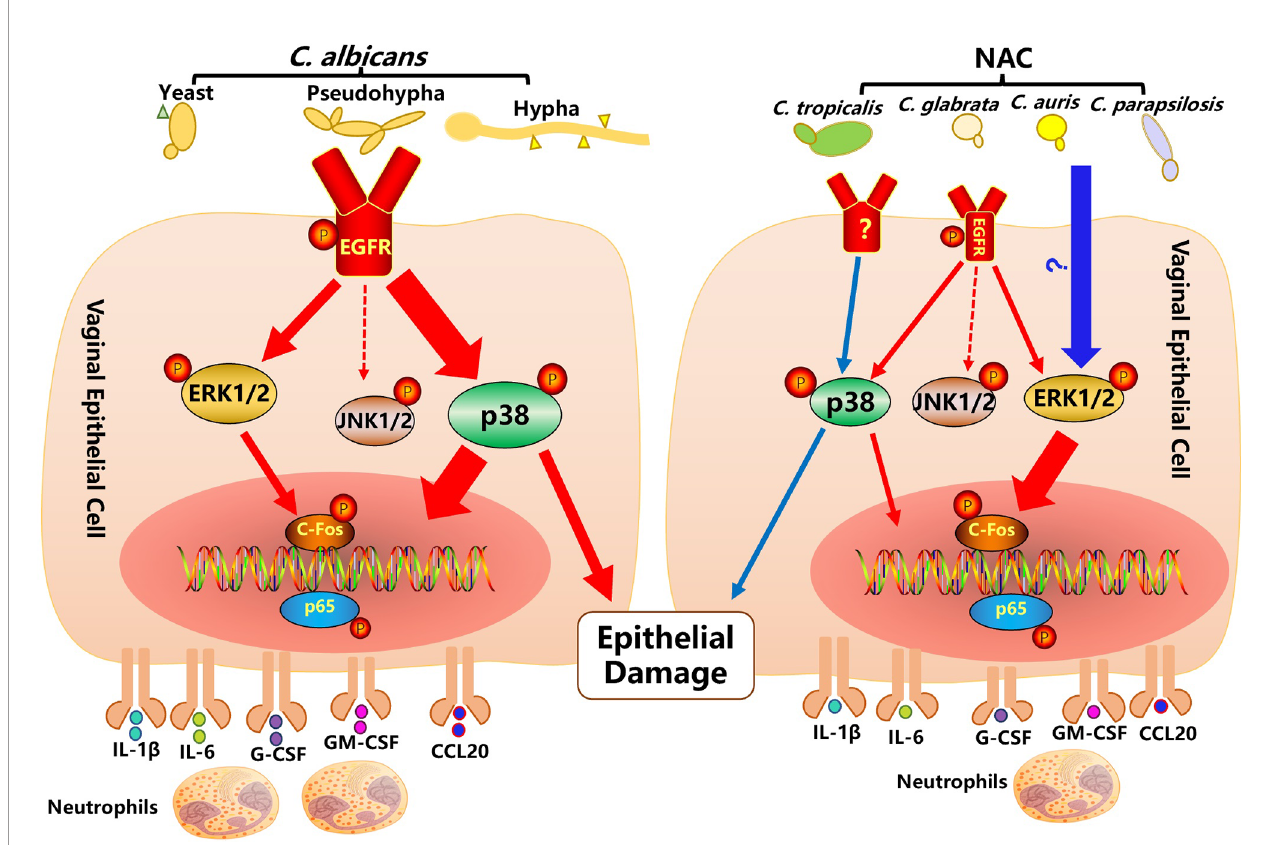
FIGURE 7 | Activation of the EGFR-MAPK signaling pathway in vaginal epithelial cells by Candida pathogens. C. albicans infection on vaginal epithelial cells manifests by a modest yeast-to-hyphal transition within the fi rst 2 hours, when the EGFR-ERK1/2 signaling pathway (small red arrow) is moderately activated. At a later stage of stimulation (4 to 10 hours), after the formation of a greater number of hyphae, the EGFR-p38 signaling pathway (thick red arrow) is strongly activated. Activated EGFR-p38 and-ERK1/2 signaling pathways lead to an increased phosphorylation of c-Fos and p65 and an increased secretion of cytokines (IL-1, IL-6, G- CSF, GM-CSF, CCL20). In particular, the EGFR-p38 signaling pathway also moderates epithelial damage induced by C. albicans . While non-albicans Candida (NAC) spp. infections of vaginal epithelial cells rarely produce hyphae, they activate a strong phosphorylation of ERK1/2, c-fos and p65 and a subsequent secretion of cytokines. Although not strongly activated, the p38 pathway still has some effect in the moderation of epithelial